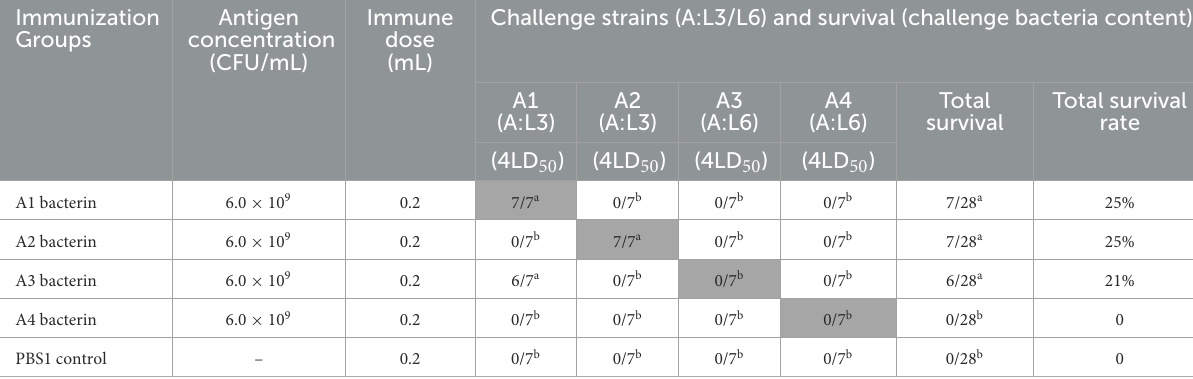
TABLE 2 Protection rate of A1–A4 bacterins against P. multocida strains (Test-1). Immunization